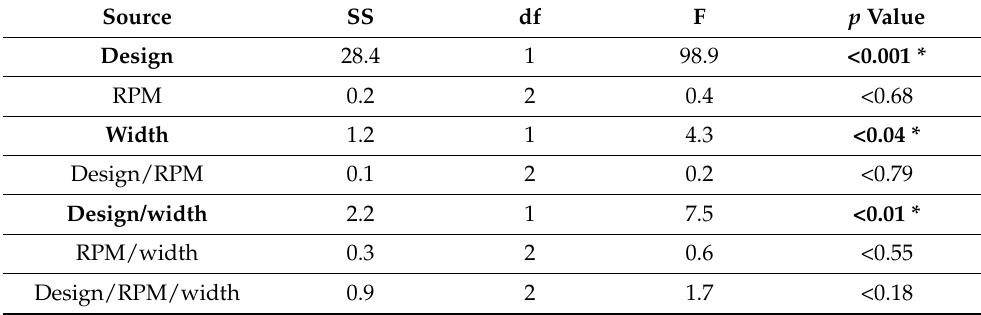
Table 2. Analysis of deviance; one-, two-, and three-way interactions between the variables.